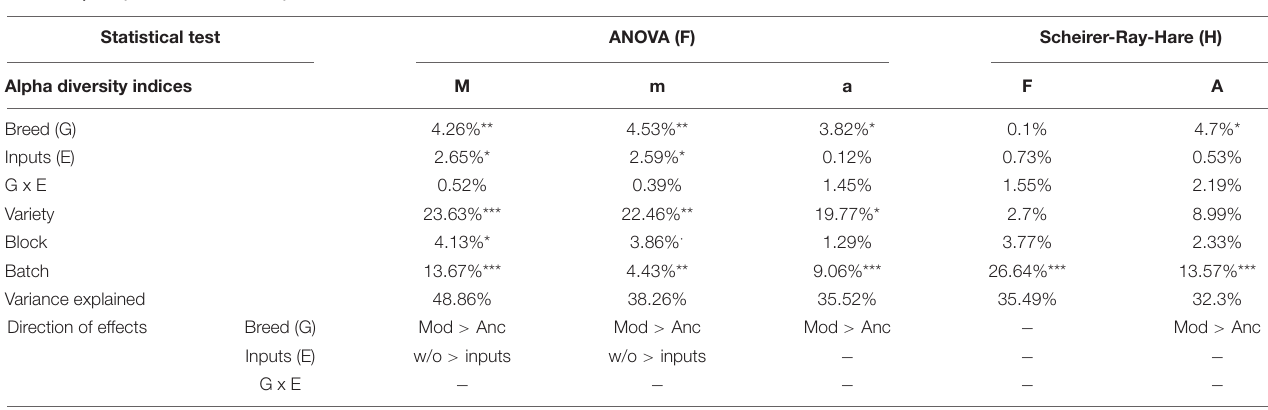
TABLE 5 | Analysis of variance for mycorrhization